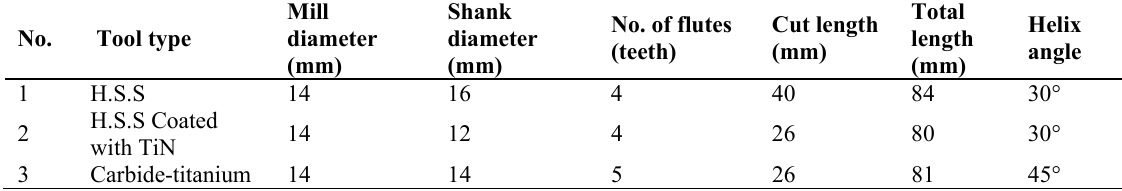
Materials and dimensions of cutting tools used in the experiments. Mill No. Tool type diameter